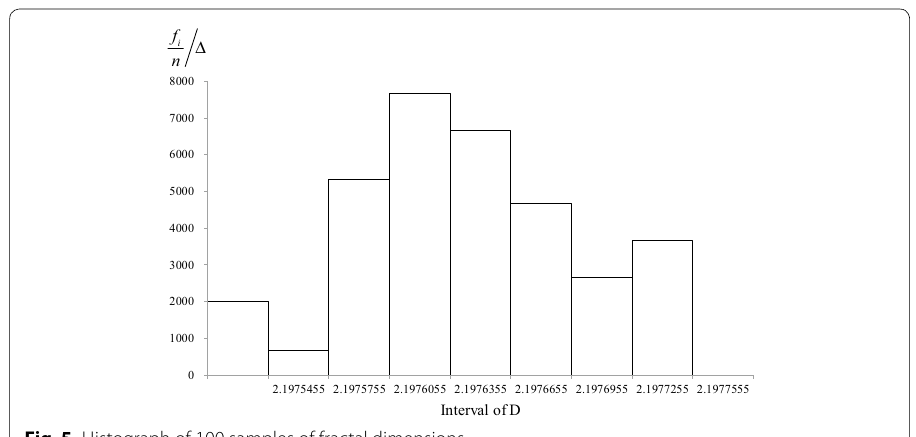
f i (cid:31) height is made in each n (cid:31)